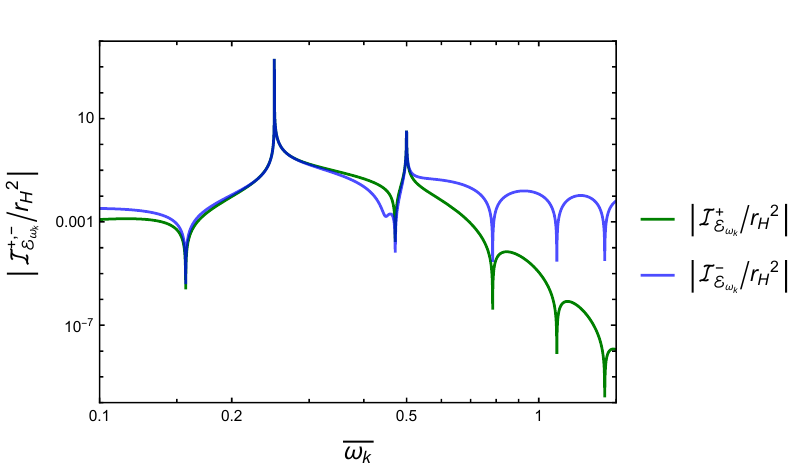
and |I − are plotted in green and blue lines, respectively | /r 2 | /r 2 H H E ωk E ωk = 10 . The detector transition energy is fixed at ∆ E = 0 . 5 . H